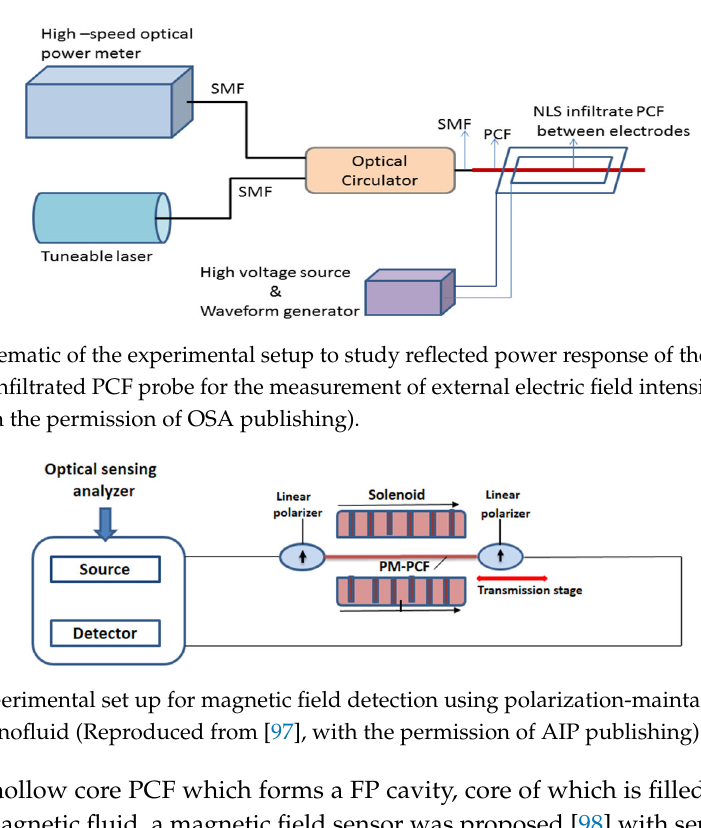
Figure 31. Schematic diagram of magnetic fluid filled hollow core PCF Fabry-Perot cavity sensor (Reproduced from [98], with the permission of Elsevier publishing).